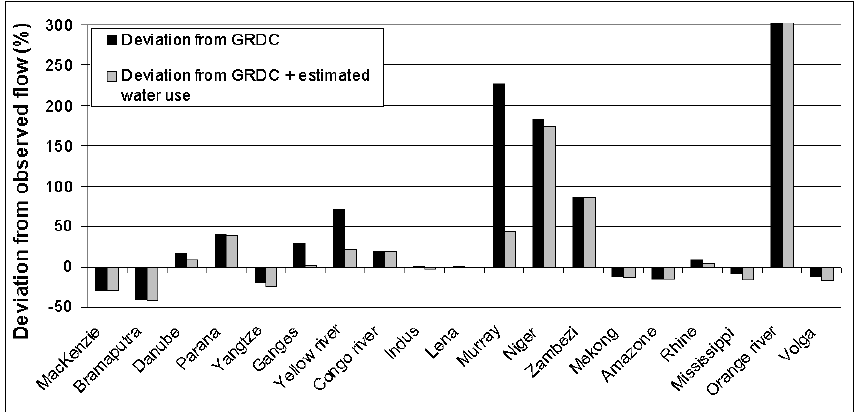
Fig. 2a. Annual mean observed discharge (GRDC), annual mean discharge calculated with PCR-GLOBWB forced with the ERA6190 dataset (PCR-GLOBWB ERA6190) and the sum of observed annual mean discharge and estimated water use (GRDC + estimated water use) as an approximation of natural flow.